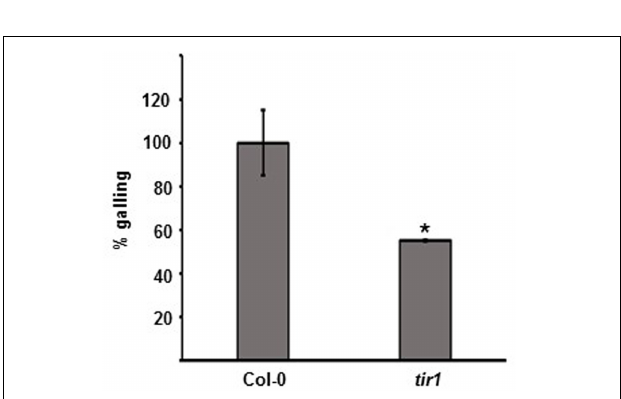
FIGURE 6 | The mutant in auxin perception tir1 is more resistant to M. hapla . Ten-day-old seedlings were inoculated with 100 M. hapla J2 per plant. Galls were counted at 14 dpi. Average galling in Col-0 was set to 100%. Values are means ± SE. Asterisk indicates a significant difference between Col-0 ( n = 58) and tir1 ( n = 37) galling (Welch t -test ∗ p < 0.01). Experiment repeated three times with similar